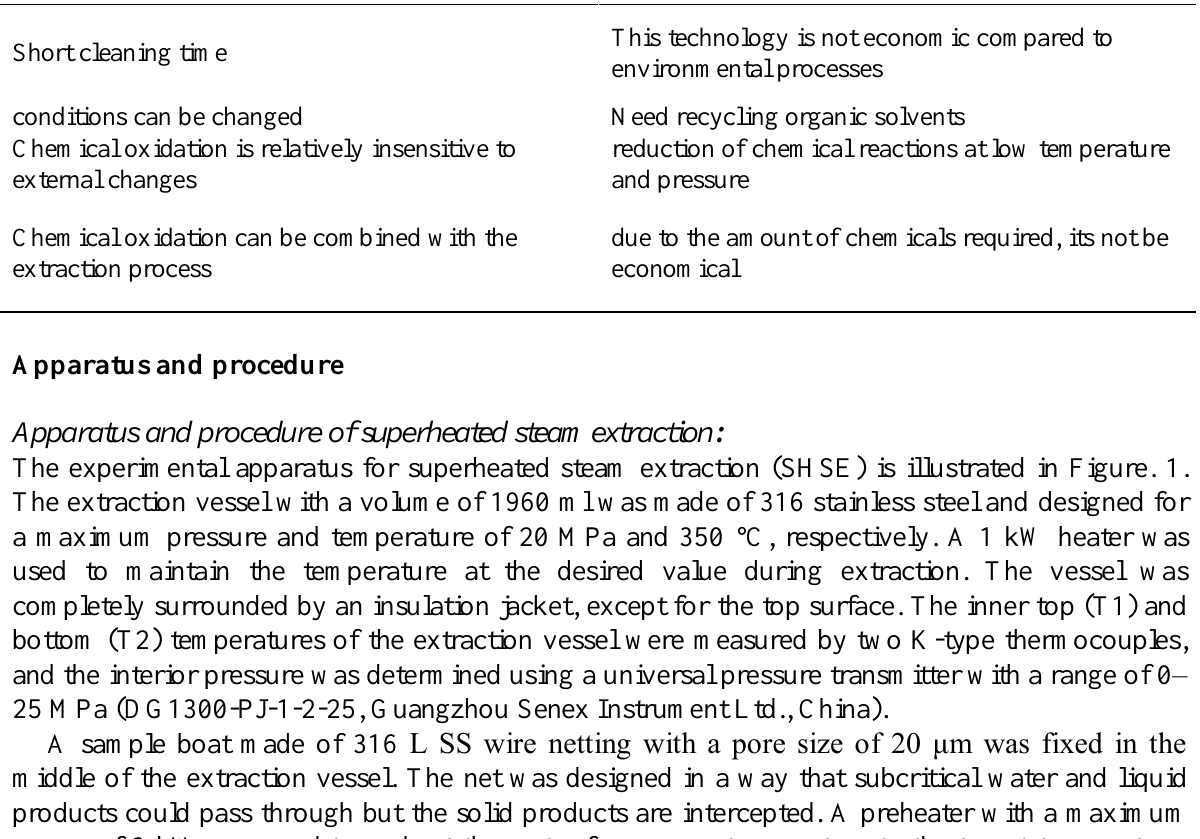
Table 1 . Advantages and Disadvantages of chemical oxidation Advantages